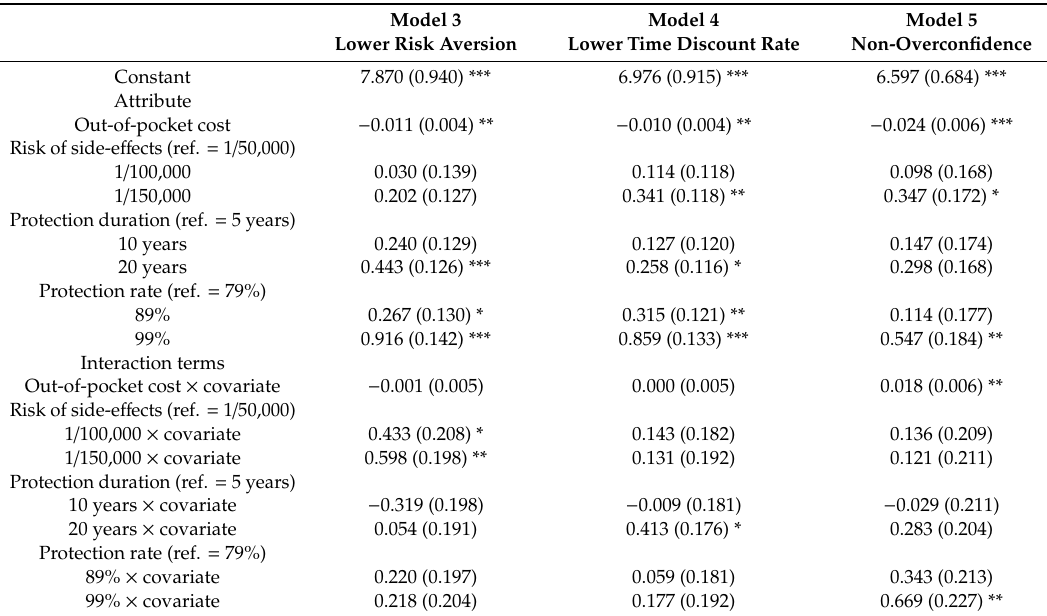
Table 4. Mixed logit model results with interactions for a discrete choice experiment addressing adults’ preferences for HBV vaccination.